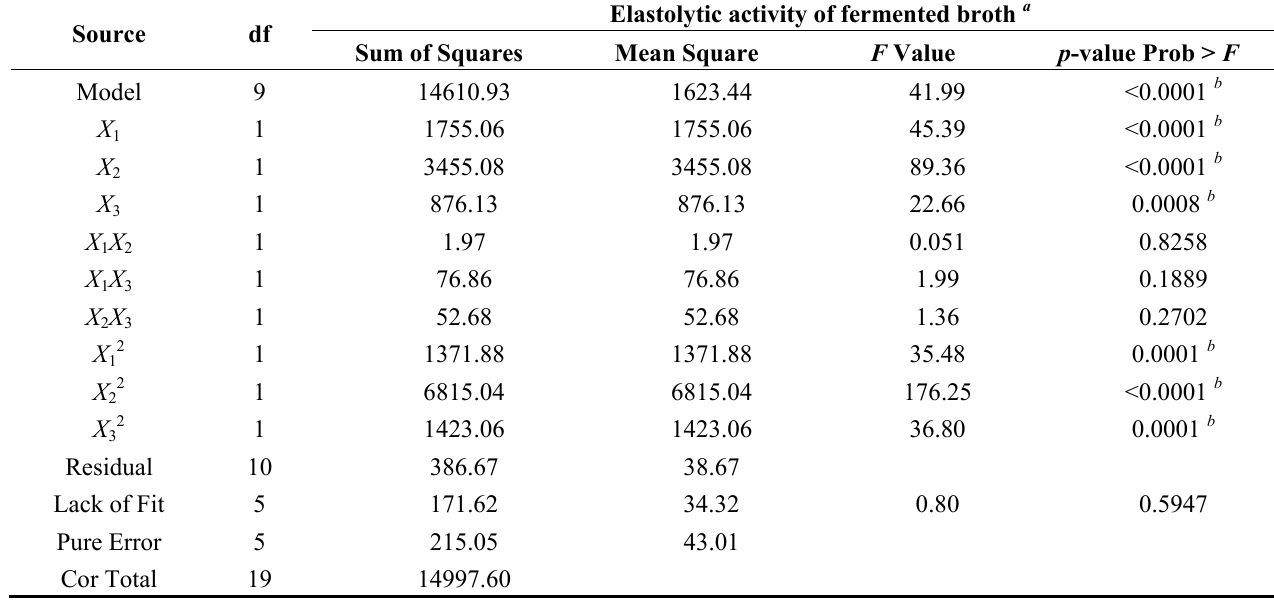
Table 3. Variance analysis of response surface quadratic model for elastolytic activity of the fermented broth of